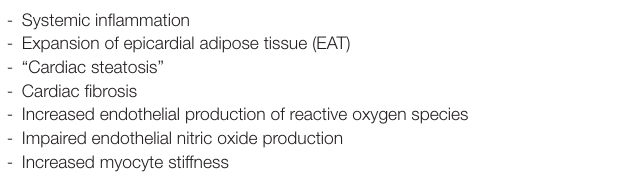
TABLE 1 | Common obesity and type 2 diabetes mellitus related HFpEF